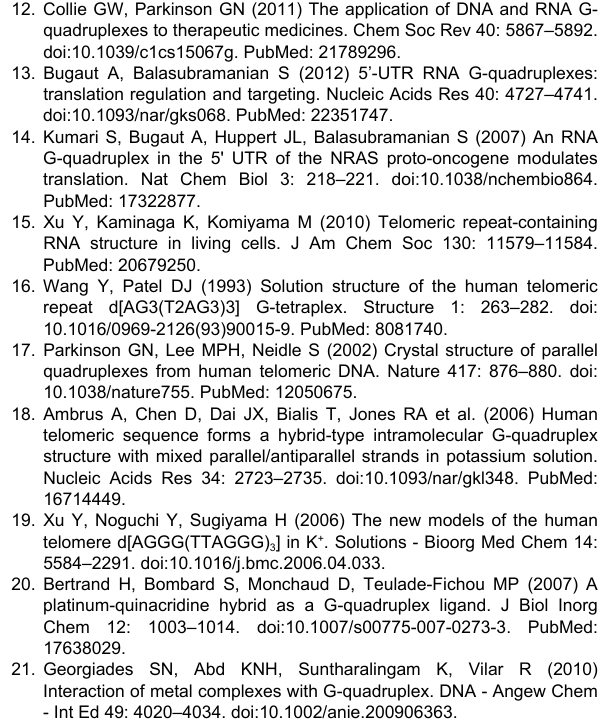
Figure S1. CD titration of 22AG with complex in 100 mM Na + or K + buffer. Titration of complex [(dmb) Ru(obip)Ru(dmb) ] 4+ with a 4 μM solution of G- 2 2 quadruplex in 100 mM NaCl buffer (a) and in 100 mM KCl buffer (b), respectively. There are slight changes in the peaks of G-quadruplexes.